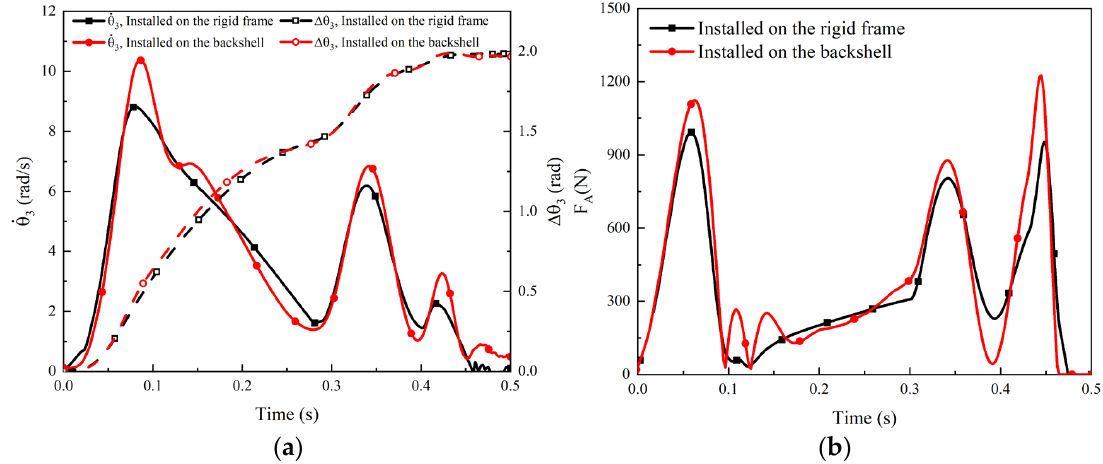
Figure 16. Comparison of the deployment performance between the FE model installed on the frame and backshell: ( a ) Deployment angle and angular velocity versus time of the flap panel; ( b ) Time history curve of the constraint reaction force.